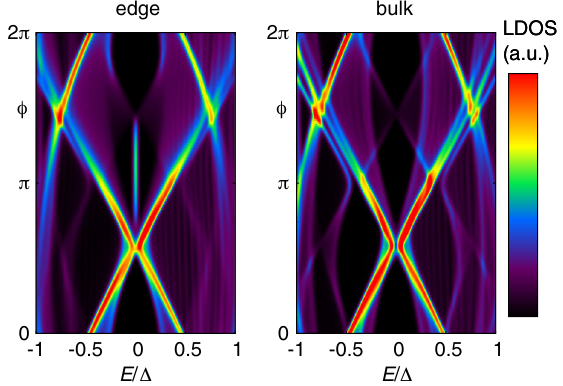
FIG. 9. Local density of states at the edge (left panel) and in the center (right panel) of the junction as a function of energy and phase difference. In a range around ϕ ¼ π , a Majorana state forms at the edge. The result is obtained numerically from a tight- binding model (see Appendix D 2) using the following param- eters (energies and length are in units of the hopping strength and 0 . 1 , Δ ¼ 0 . 25 , μ ¼ E lattice spacing): α ¼ 0 . 5 , E Z;J ¼ Z;L ¼ − 3 . 75 (measured from the center of the tight-binding band), junction width W ¼ 4 , width of the superconducting leads 8 , and length L ¼ 200 . We plot a spatial average of W SC ¼ the density of states over a rectangle spanning the entire width of the junction in the y directions and the first 10 sites from the edge (left panel) or the most central 10 sites (right panel) in the x direction. For presentation, the local density of states has been convoluted with a Gaussian with a standard deviation of 0 . 02 Δ